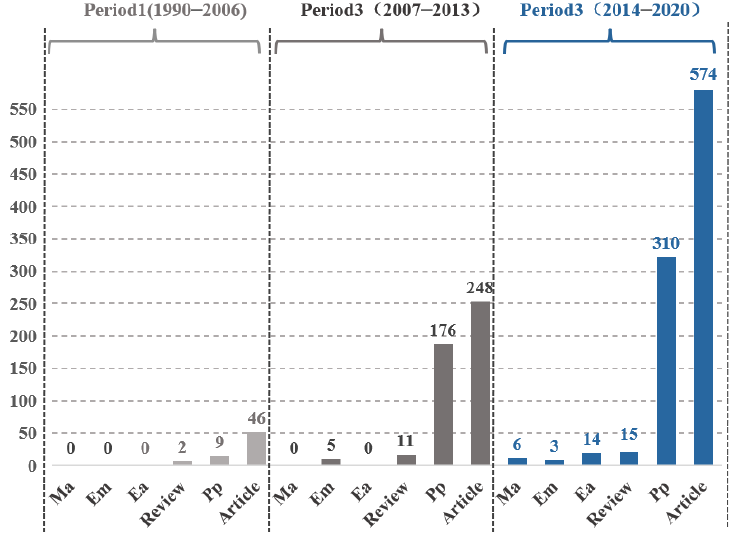
Figure 1. The number of retrieved documents by type and period of publication.